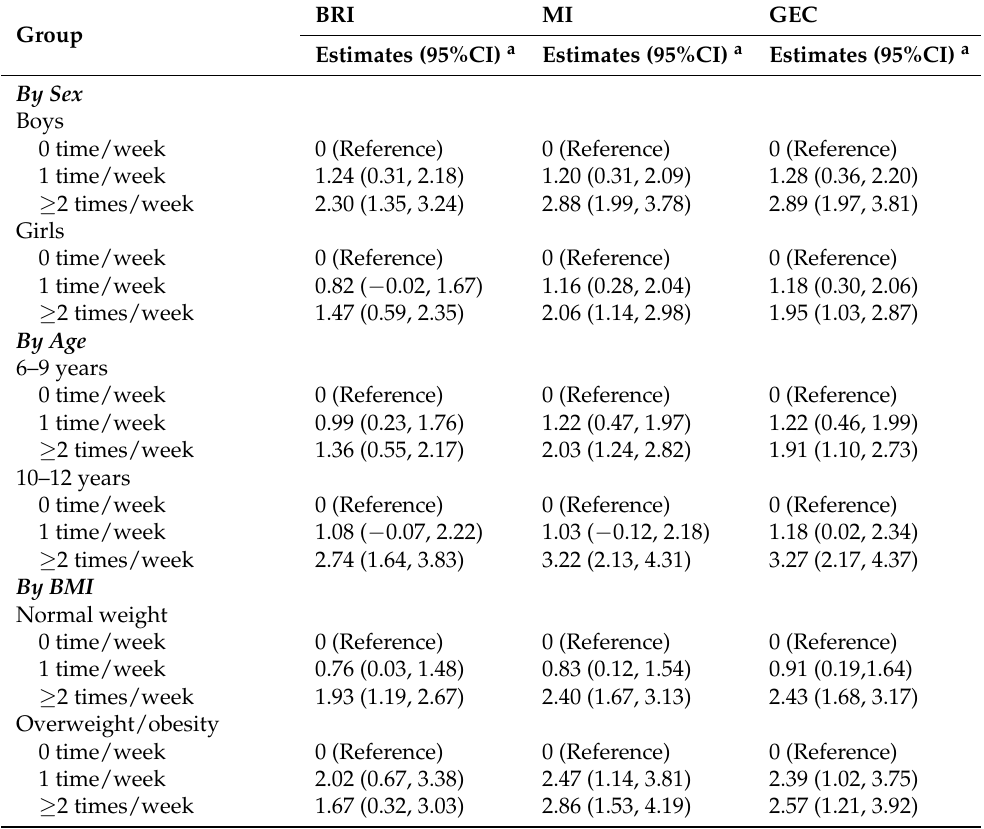
Table A3. SSB and executive function stratified by sex, age, and weight ( n =